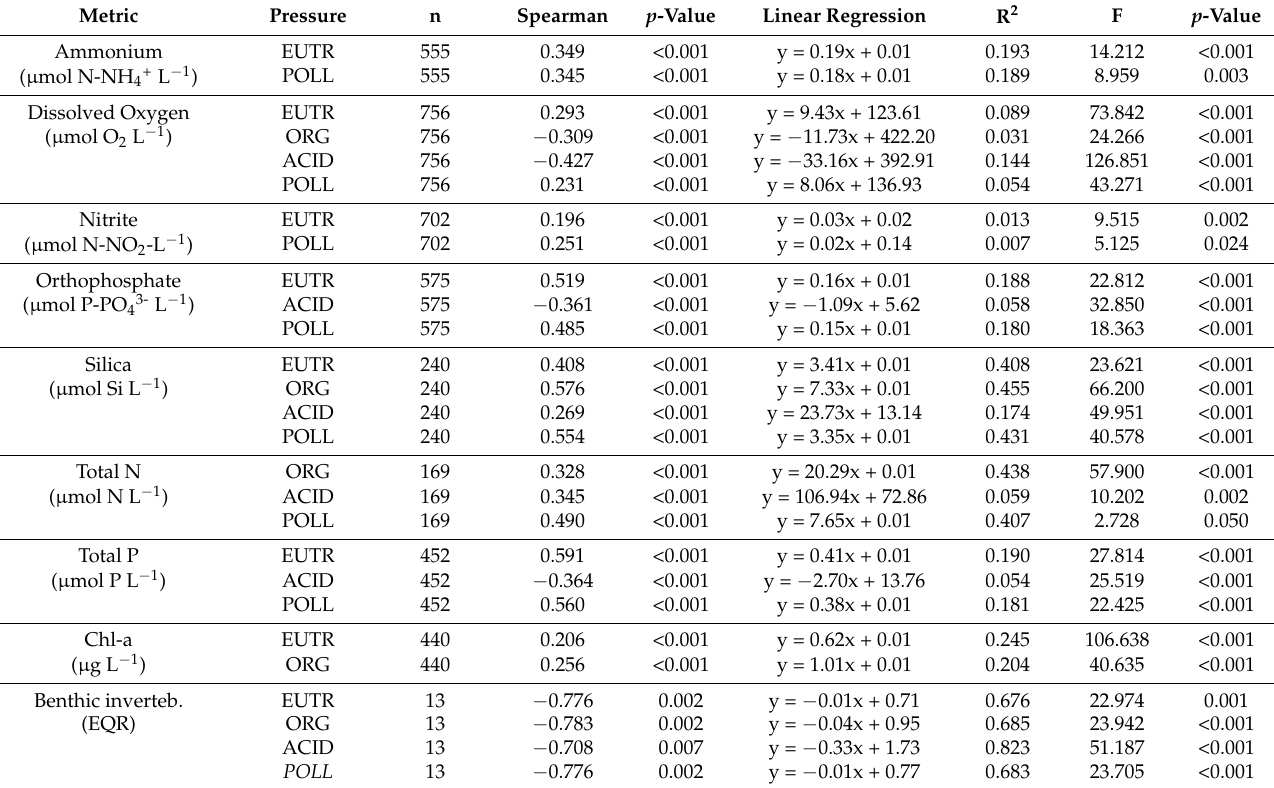
Table 4. Correlation and linear regression of the physical and chemical indicators and biological quality elements with each of the pressure types defined (EUTR: eutrophication, ORG: organic enrichment, ACID: acidification, POLL: presence of toxic pollutants). Only statistically significant correlations and regressions with p -value < 0.05 are reported here. n = number of corresponding metrics data used for the